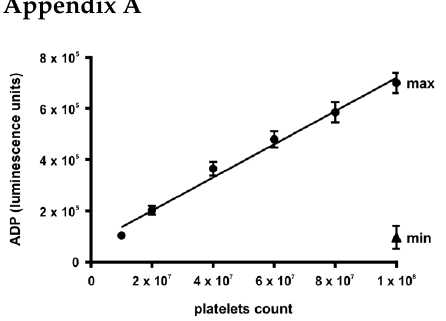
Figure A1. Standard curve of ADP luminescence. ADP release from 1 × 10 7 to 1 × 10 8 platelets was measured by enzymatic conversion of ADP to ATP measured in luminescence arbitrary units. Minimum ADP release taken from the supernatant of pelleted 1 × 10 8 platelets (MIN), and maximum ADP release was assessed from the supernatant of 1 × 10 8 platelets sonicated (MAX).